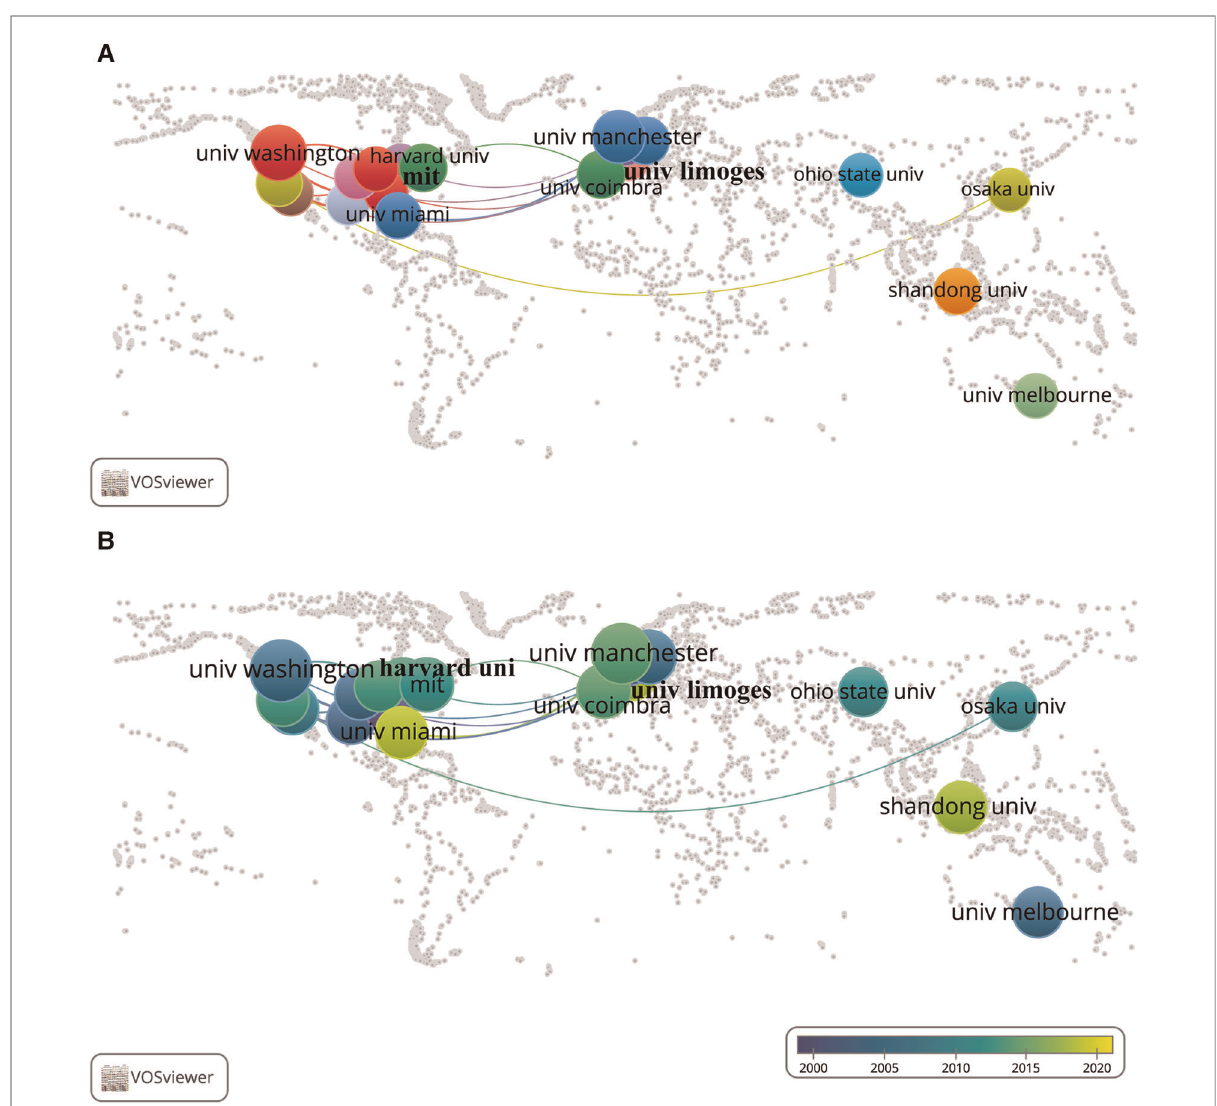
FIGURE 6 Institution cooperation networks. Each node represents an institution, and each line represents a link between two institutions. The size of each node represents the number of documents, and the thickness of each line represents the strength of the link. ( A ) Institutional cooperation network map of institutional co-authorship among the top 21 most productive institutions. The colour of each node represents the clusters of each institution. ( B ) Institutional co-authorship time-overlay map of cooperation networks among the top 21 most productive institutions. The colour of each node represents the average publication year, according to the colour gradient presented in the lower right